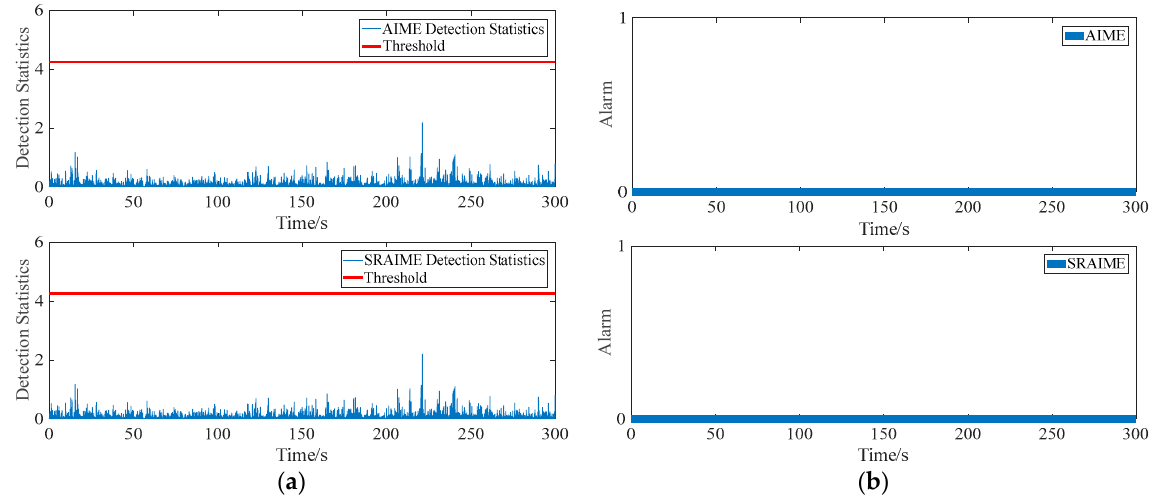
Figure 5. Suntuan River Bridge slow-varying gross error detection results by GNSS/accelerometer fusion: ( a ) Gross error detection statistics; ( b ) Gross error detection alarm condition.